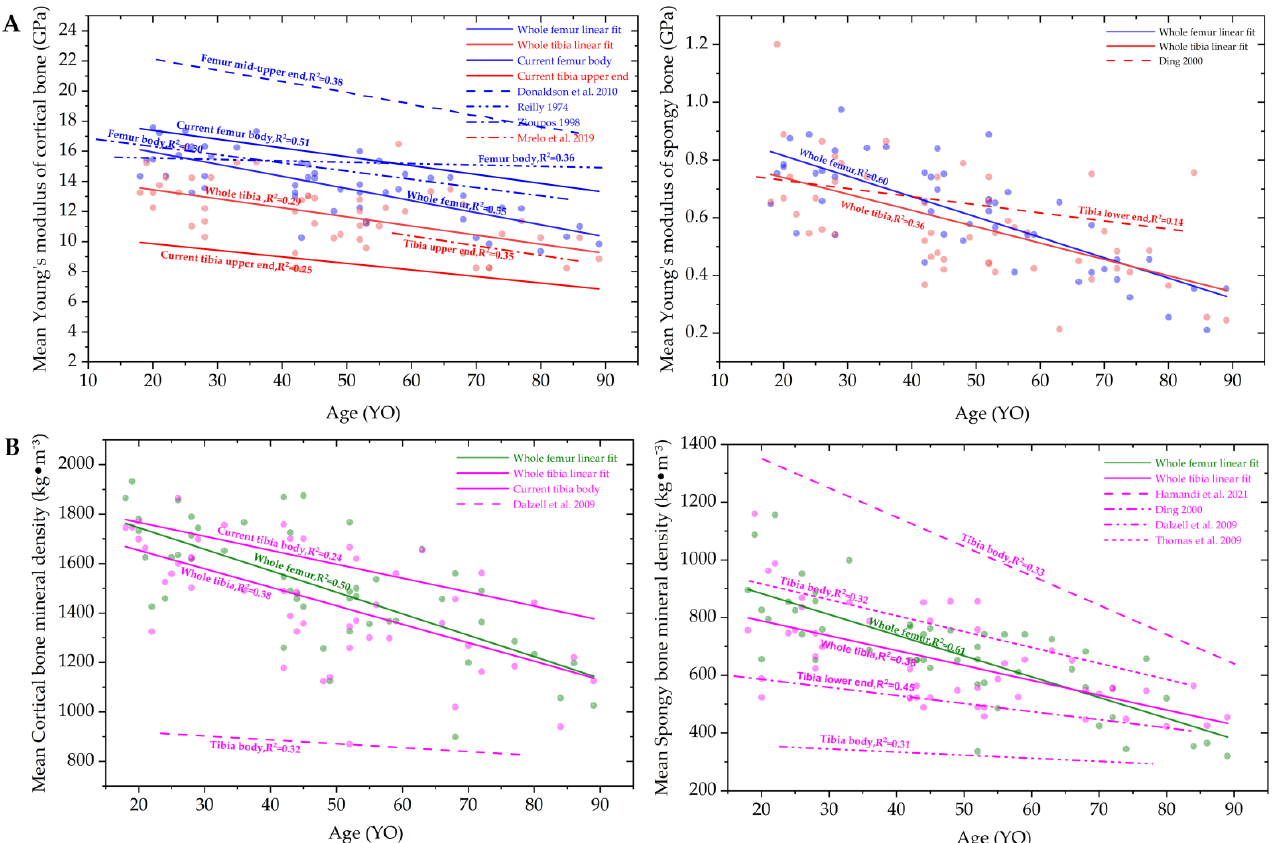
Figure 4. Linear fitting of Young’s modulus ( A ) and bone mineral density ( B ) of long bone corti- cal/spongy bone (Adapted from [22,25,44–49].)